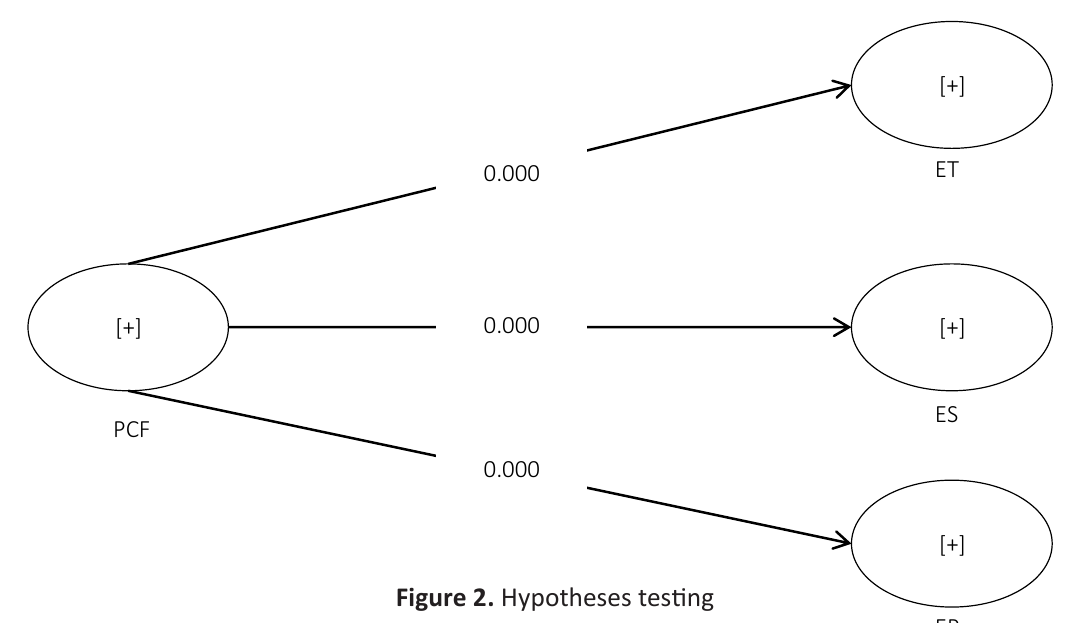
Figure 2. Hypotheses